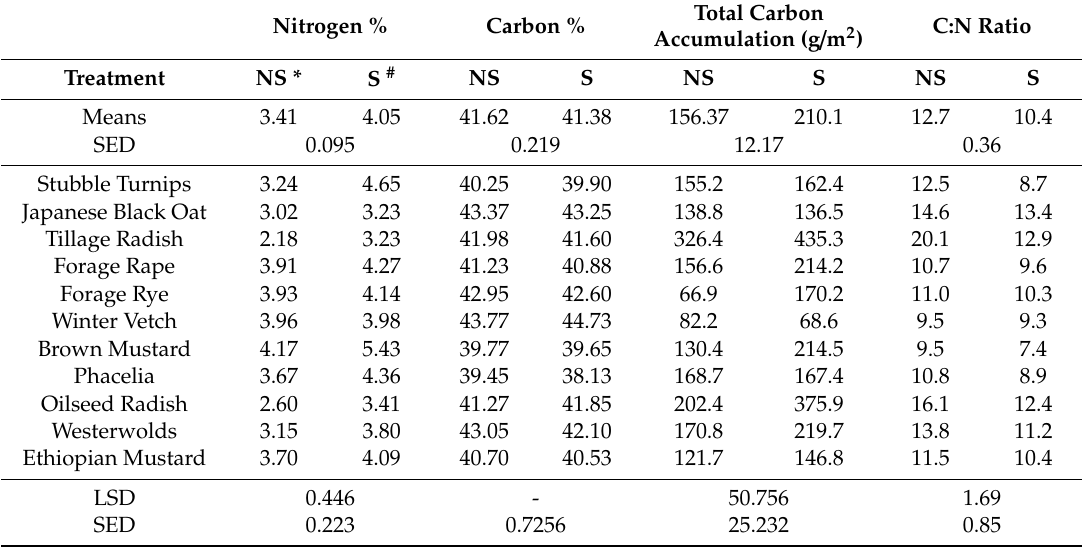
Table A4. Treatment means of nitrogen and carbon concentration and accumulation including C:N ratio in response to slurry.